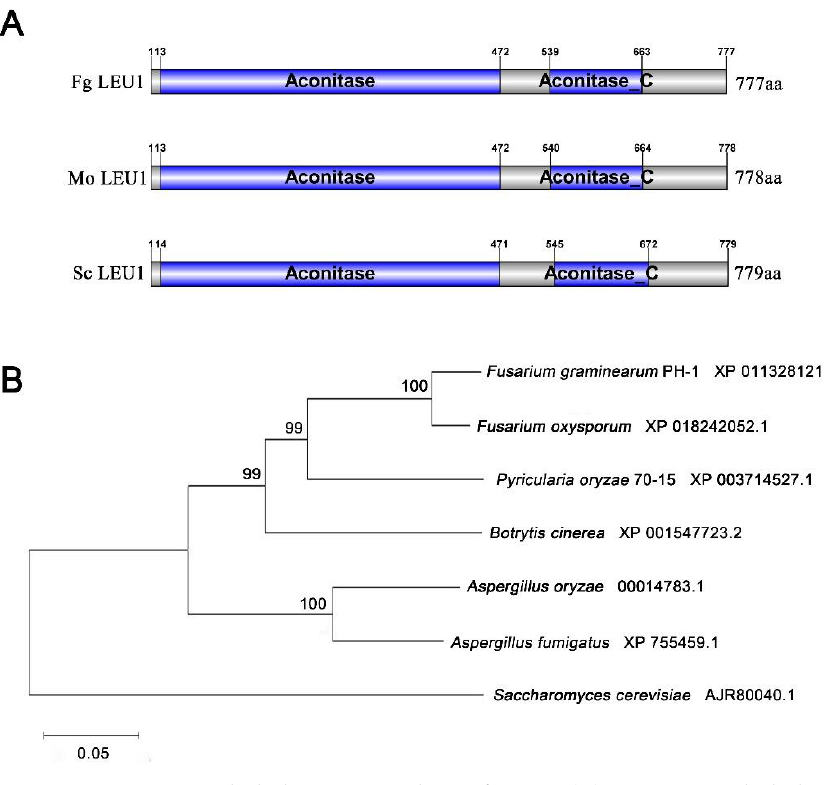
Figure 1. Sequence and phylogenetic analysis of LEU1. ( A ) Sequence and phylogenetic analysis of LEU1 in Fusarium graminearum (Fg), Magnaporthe oryzae (Mo), and Saccharomyces cerevisiae (Sc). Aconitase: An enzyme that catalyzes the stereo-specific isomerization of citrate to isocitrate via cis-aconitate in the tricarboxylic acid cycle through a non-redox-active process. Aconitase C: The Aconitase C-terminal domain, which undergoes conformational change in the enzyme mechanism. ( B ) A phylogenetic tree of LEU1 with homologues from other fungal species was constructed using the neighbor-joining method in MEGA version 7.0. Numbers at the nodes in the rooted tree represent the bootstrap value after 1000 replications. GenBank accession numbers are presented after the fungal species names. The bar indicates 0.05 distance units.